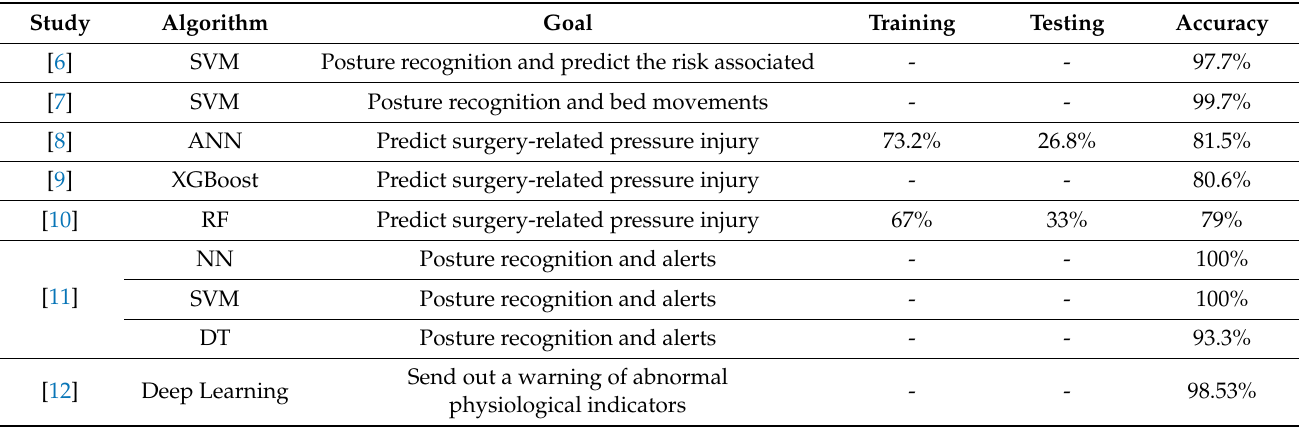
Table 6. Details of the predictive model ( n =